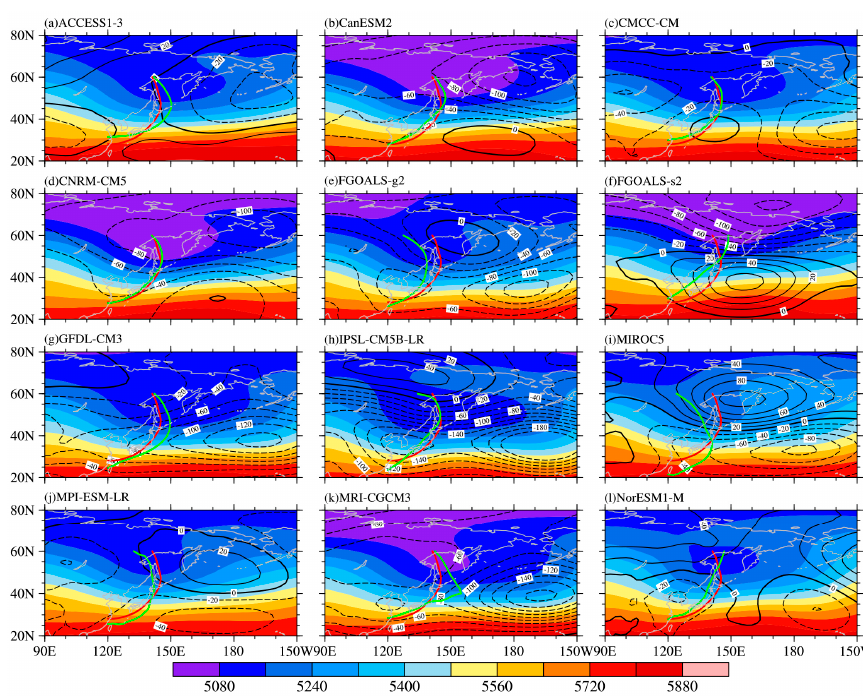
Figure 2. Climatological mean of the geopotential height at 500 hPa in individual CMIP5 models (colors, gpm) and its difference from the observations (contours, interval is 20 gpm). The red (green) lines represent the trough line in the observations (individual CMIP5 models). ( a – l ) represent different CMIP5 models as indicated at top left in each panel.